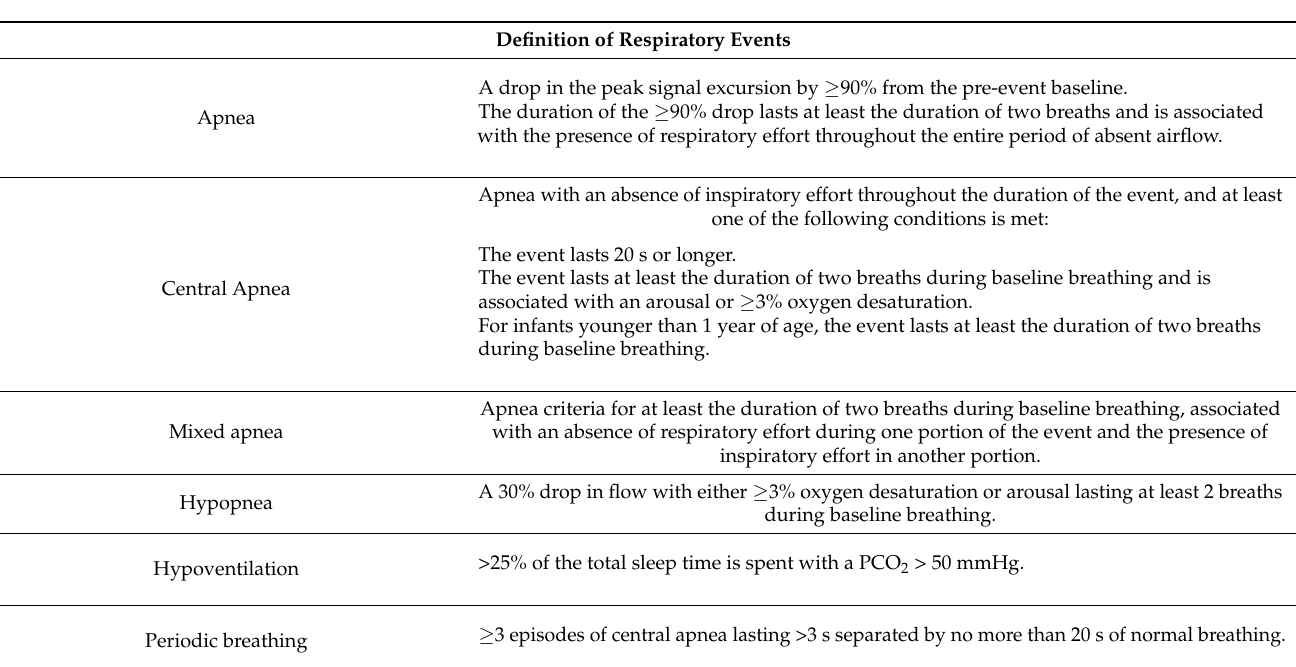
Table 2. American Academy of Sleep Medicine (AASM): Updated pediatric scoring rules [18].